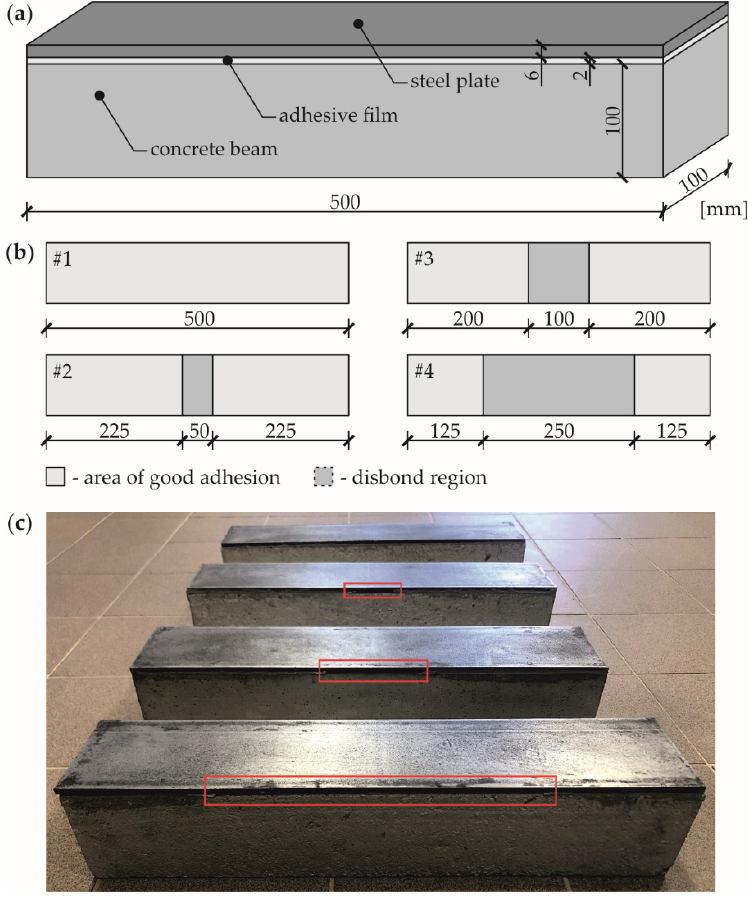
Figure 1. Object of research: ( a ) Specimen geometry; ( b ) variants of defects; ( c ) photograph of experimental samples. Table 1. Material parameters of the consisting elements of the composite beam.